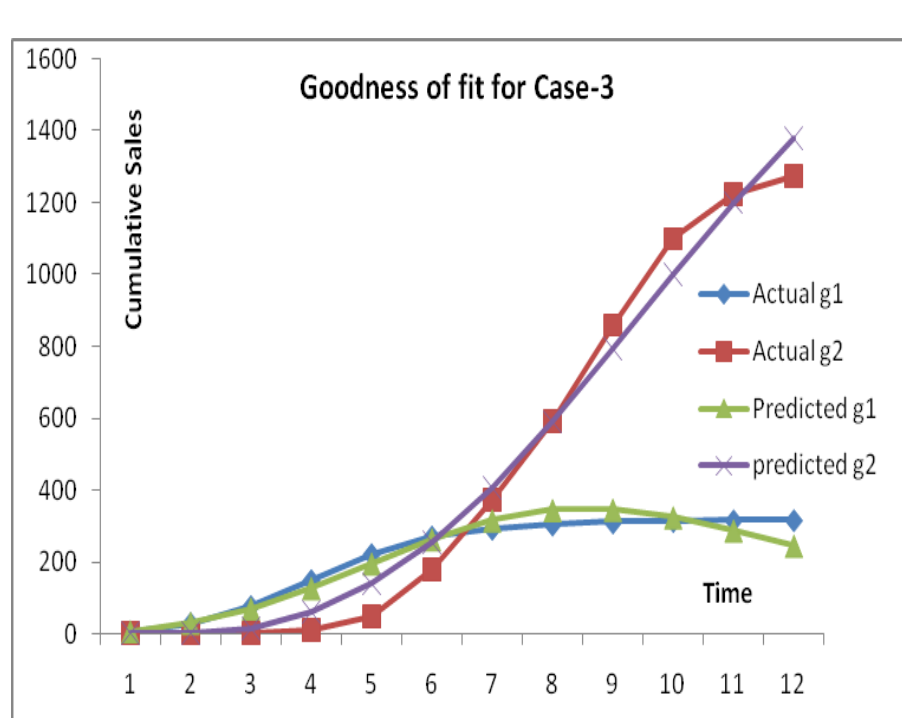
Fig. 3. Goodness of fit curve for